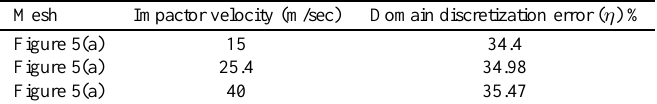
Table 2 Discretization error for varying impactor velocity with constant Mi/Mp ratio